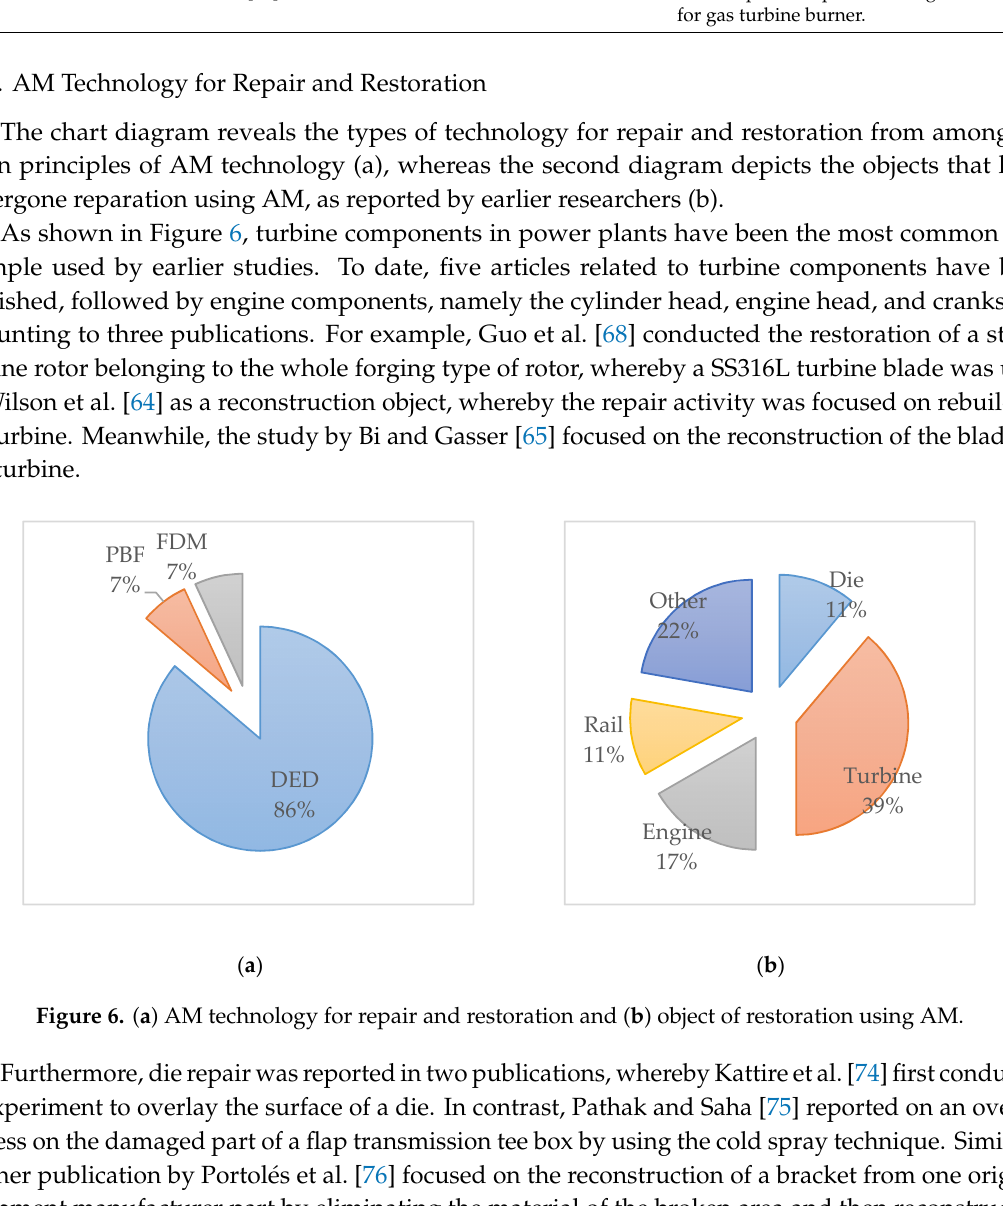
( b ) Figure 7 .(a) Damaged tip and (b) reconstructed tip reproduced with permission from Wilson et.al [64], Journal of Cleaner Production; published by Elsevier, 2014.